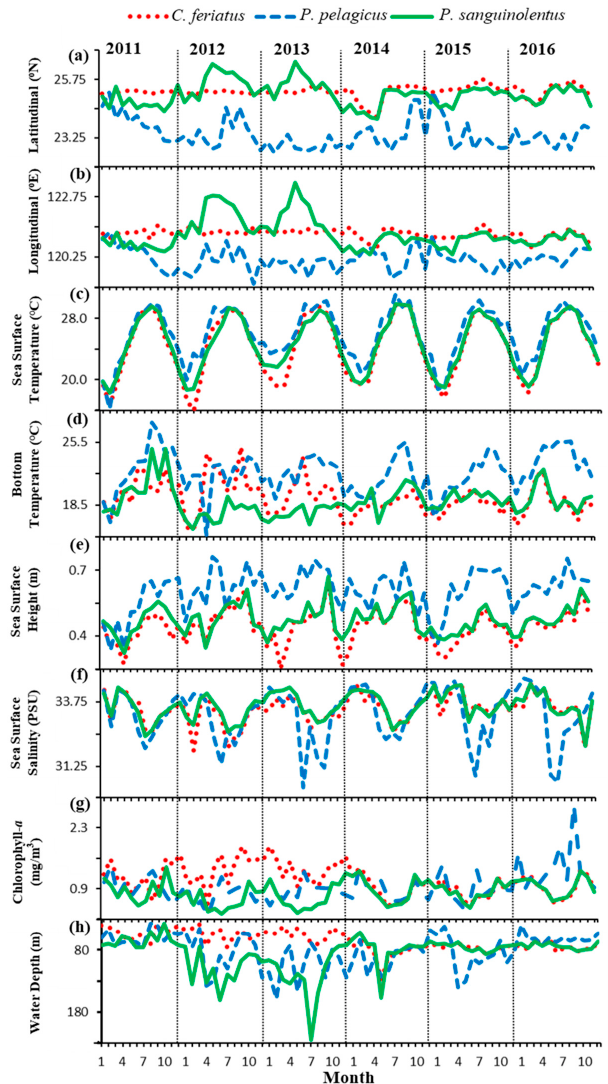
Figure 3. Monthly mean trends of ( a ) latitudinal (Lat.) and ( b ) longitudinal (Lon.) gravitational centers of observed catch rates ( G ) of C . feriatus , P. pelagicus , and P. sanguinolentus , presented in relation to the monthly mean values of ( c ) sea surface temperature (SST); ( d ) bottom temperature (BT); ( e ) sea surface height (SSH); ( f ) sea surface salinity (SSS); ( g ) chlorophylla- a (Chl- a ); and ( h ) water depth (Depth) in the TS.